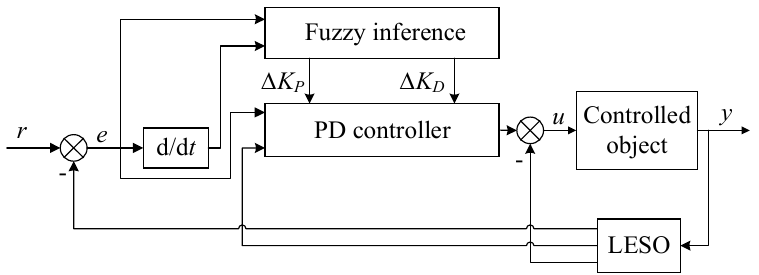
Figure 7. fuzzy logic system with linear extended state observer. Figure 7. Fuzzy logic system with linear extended state